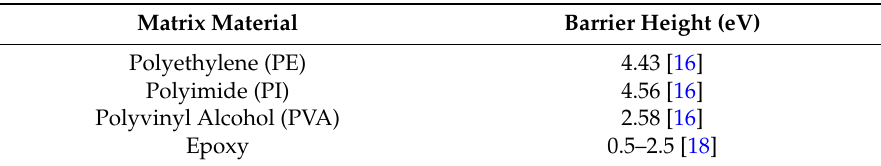
Table 2. Average barrier height of various polymer materials.